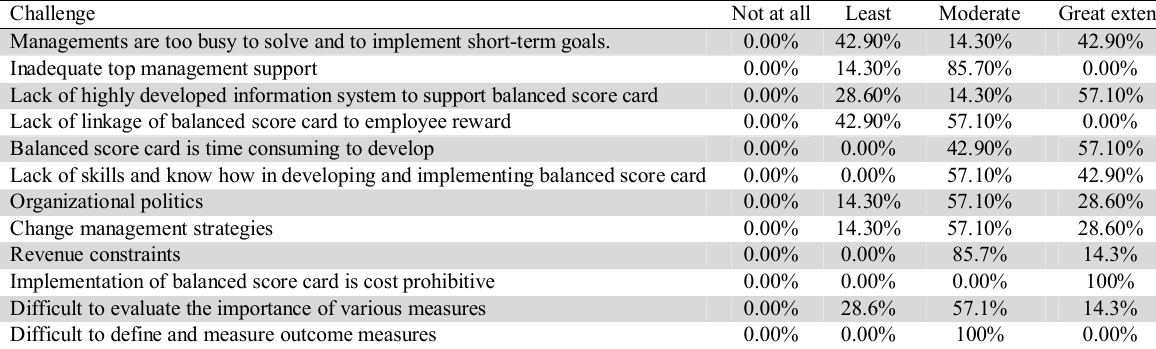
Challenges of using balanced scorecard to measure performance Challenge Challenge Not at all Least Moderate Great extent Managements are too busy to solve and to implement short-term